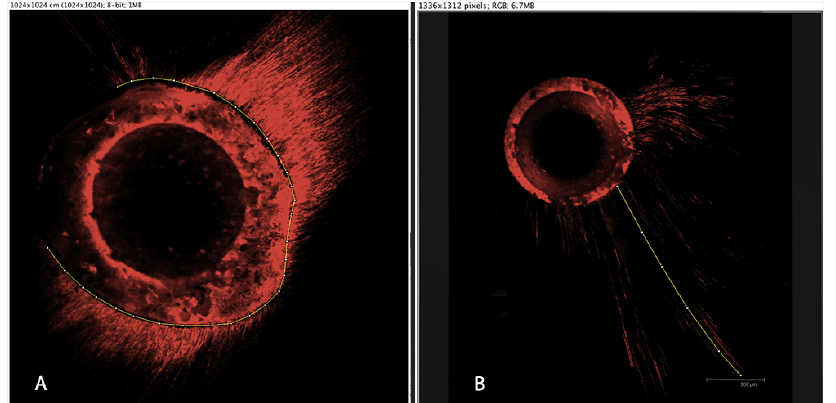
Figure 1. Representative images of the measurement of the tubular perimeter penetrated by cement ( A ) and the dentin tubule penetration depth (panel B ). The central rounded unstained portion of the image represents gutta-percha. The surrounding stained portion represents the sealer. The prolongations of the stained portion represent the sealer penetration inside the dentinal tubules.